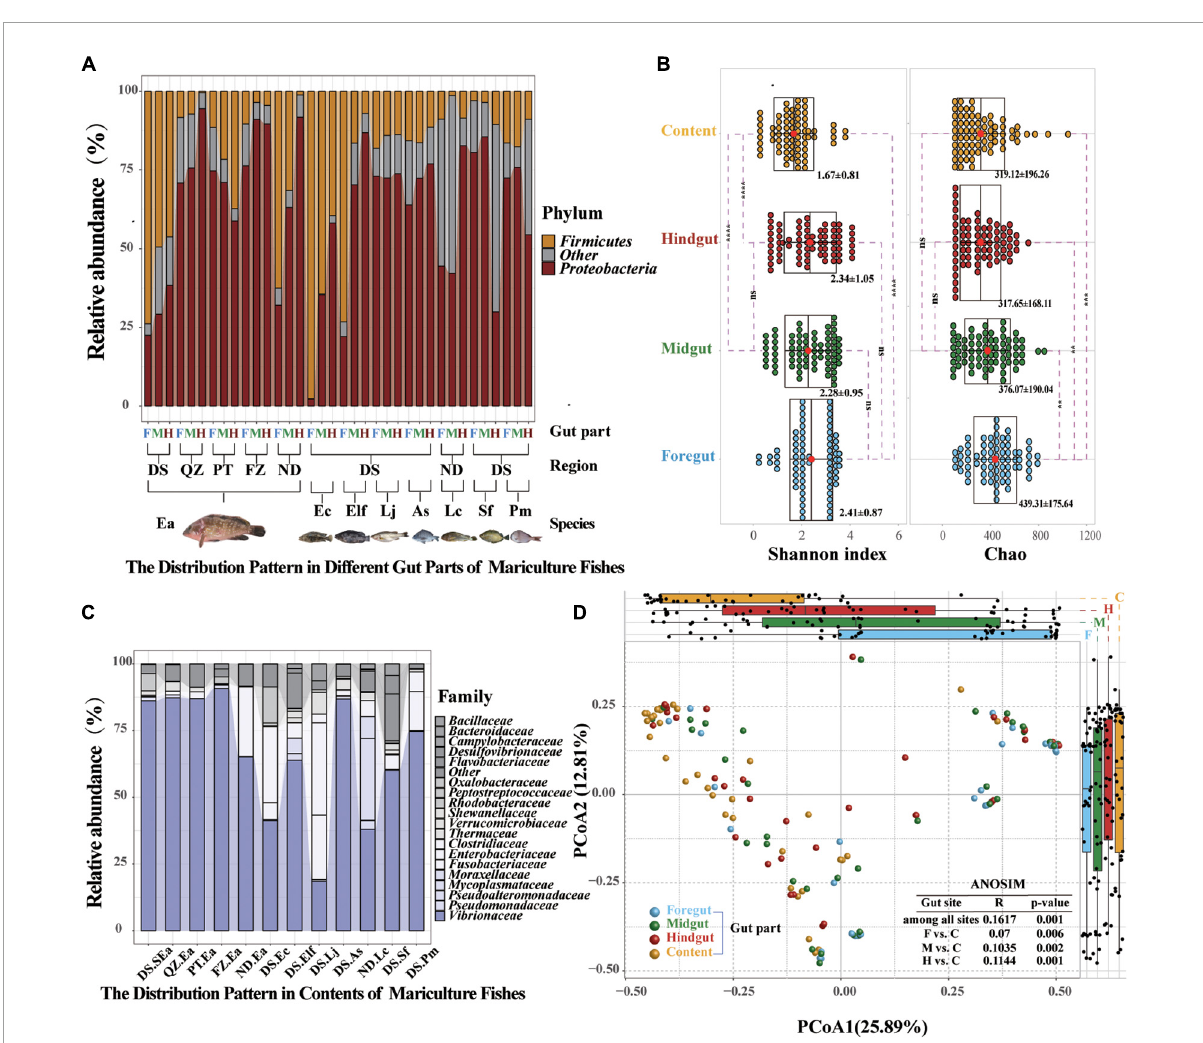
FIGURE4 Common distribution characteristics by gut parts are visible shaping marine commercial fish microbial communities. (A) Relative abundance of the microbial communities at the phylum level found in different gut compartments (foregut, midgut, and hindgut). Each group represents nine fish individuals with a parallel sample mixed by three individuals. Only Proteobacteria and Firmicutes of different gut parts are plotted. (B) Relative abundance of the microbial communities at the family level found in the content. Only the dominant microbial family with top 20 of the content are plotted. (C) α -Diversity comparison based on the Shannon diversity index in each of the parts using ANOVA to determine significant differences (** p ≤ 0.05; *** p ≤ 0.005; **** p ≤ 0.0005; and ns p > 0.05). In data shown as a combination of dot plots and box plots ( n = 108 fish individuals), with the center red point indicates the mean value in the corresponding group, and the data are expressed as the means ± SD. (D) Principal coordinate analysis plot generated using OTU metrics based on the Bray–Curtis dissimilarities. Each point represents a sample. Differences were assessed by ANOSIM and significance was established at p < 0.05. An R -value close to “1” suggests dissimilarity between groups, whereas an R -value close to “0” suggests an even distribution of high and low ranks within and between